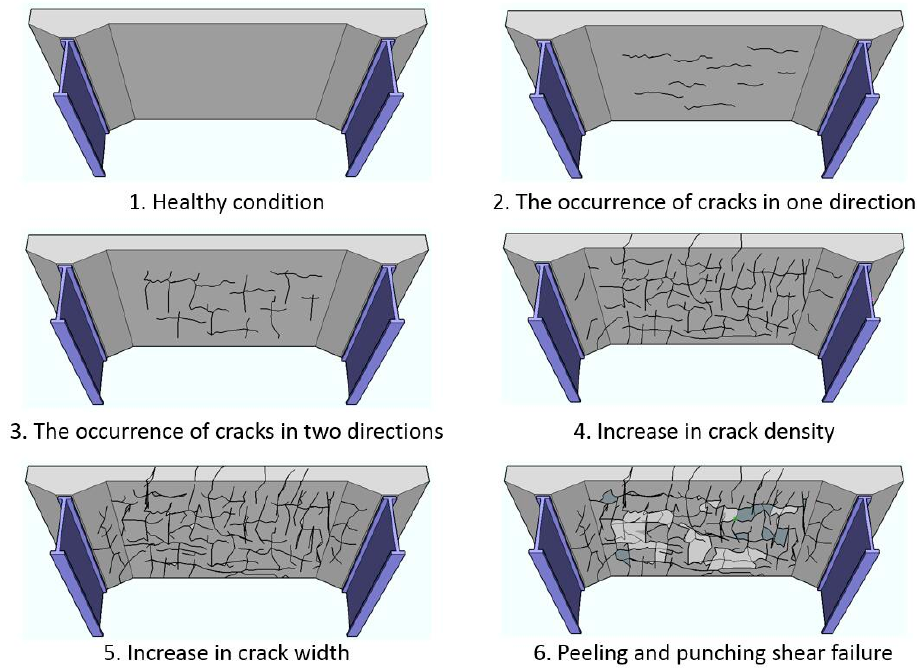
Figure 12. Crack progress and deterioration process of an RC slab.